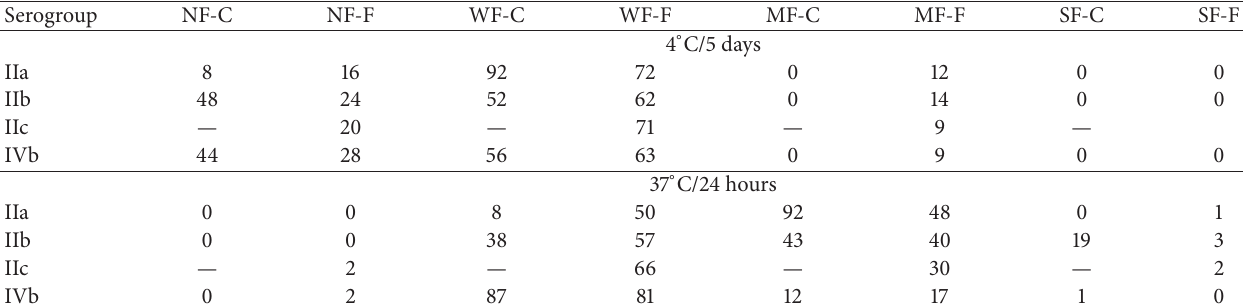
Table 1: Classification of food and clinical isolates belonging to different serogroups isolates concerning their ability to form biofilm during five days at 4 ∘ C and 24 hours at 37 ∘ C (results are expressed as % of isolates). Serogroup